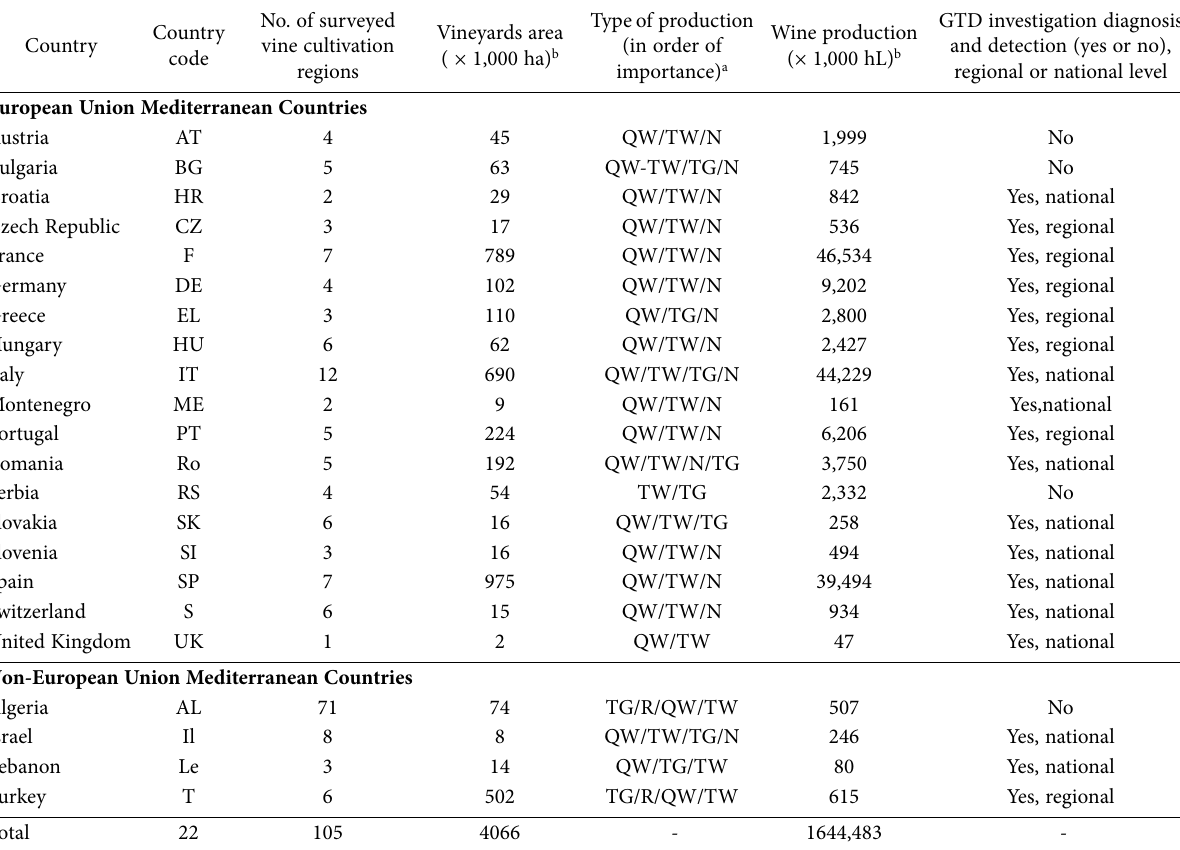
Table 1. General characteristics of grapevine production in surveyed European and Mediterranean countries. No. of surveyed Type of production GTD investigation diagnosis Country Wine production Vineyards area Country vine cultivation (in order of and detection (yes or no), code (× 1,000 hL) b ( × 1,000 ha) b regions importance) a regional or national level